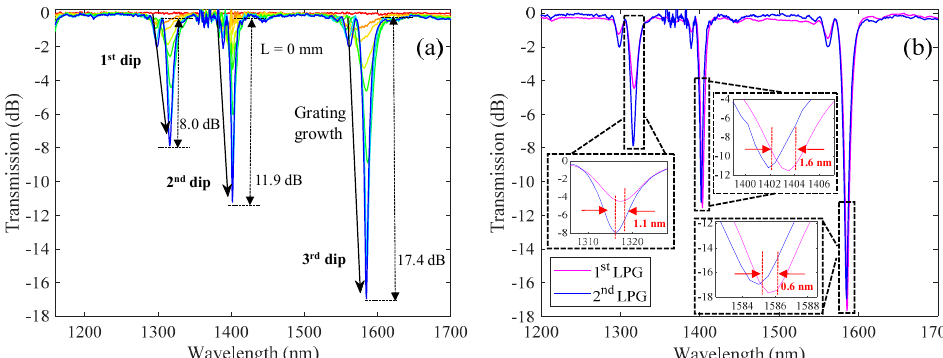
Figure 8. ( a ) Transmission spectra acquired during the grating inscription, for an LPG written with the same conditions as the one presented in Figure 6, (i.e., scanning the UV laser beam (E = 3.9 mJ, R = 500 Hz), with velocity of 125 µm/s along a 690 µm period amplitude mask). ( b ) Transmission spectra of two ~38 mm LPGs, either from the results collected in Figure 6 (1st LPG) and for a new grating with similar writing parameters (2nd LPG).